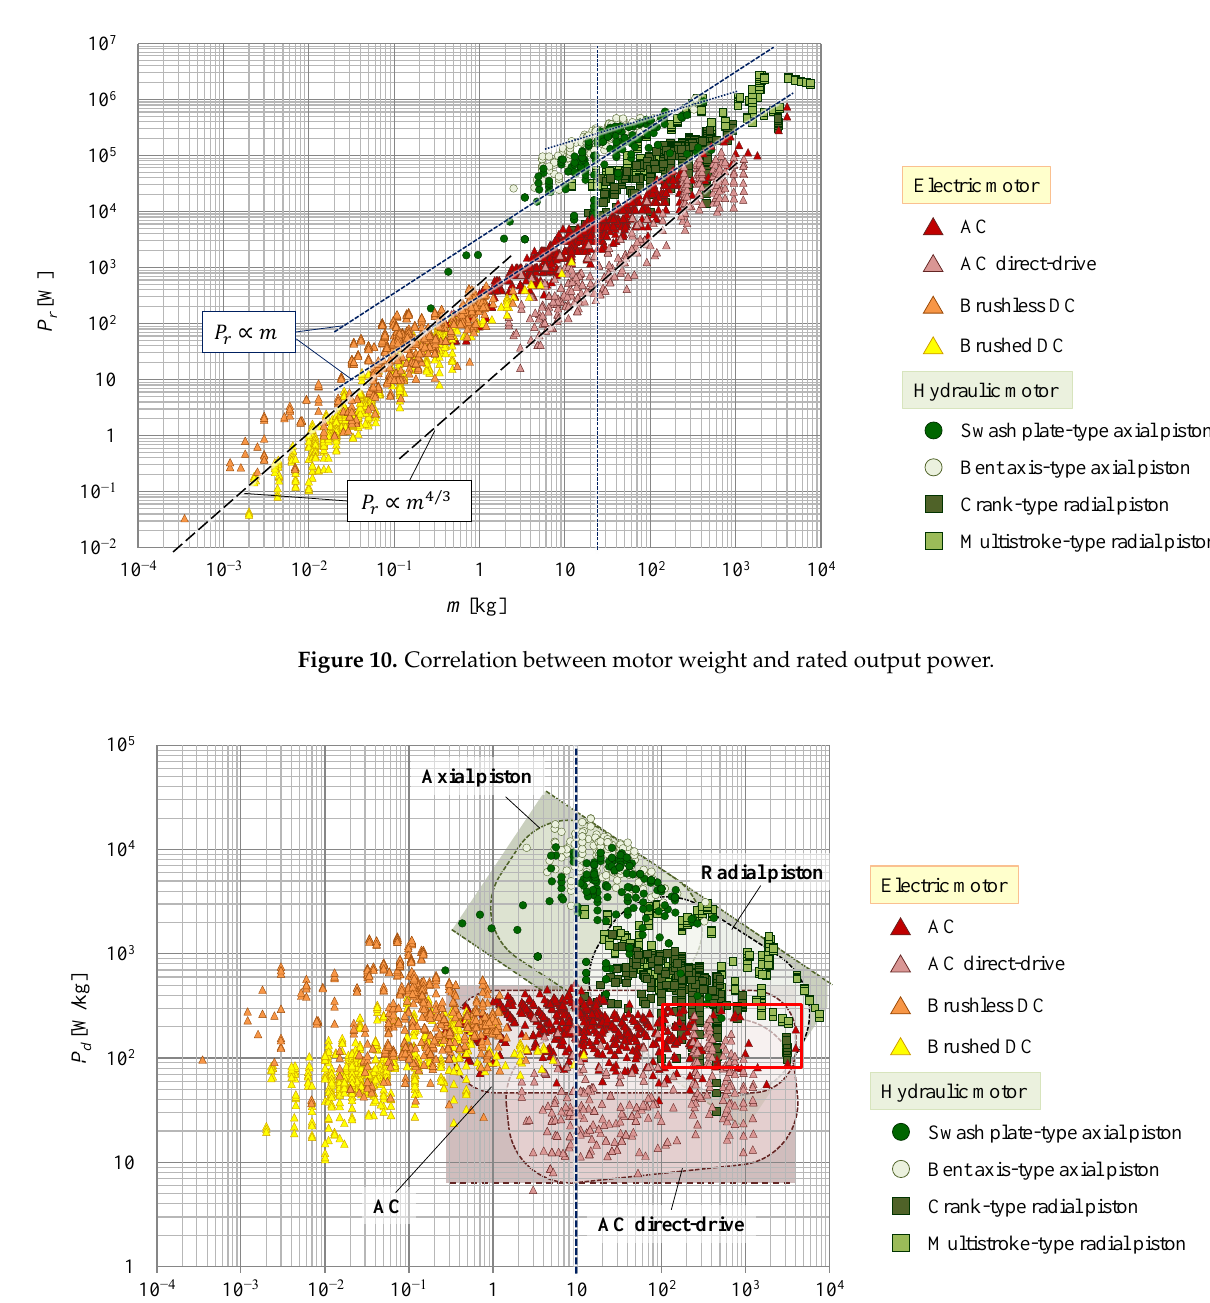
m Figure 11. Correlation between motor weight and power Figure 11. Correlation between motor weight and power density.